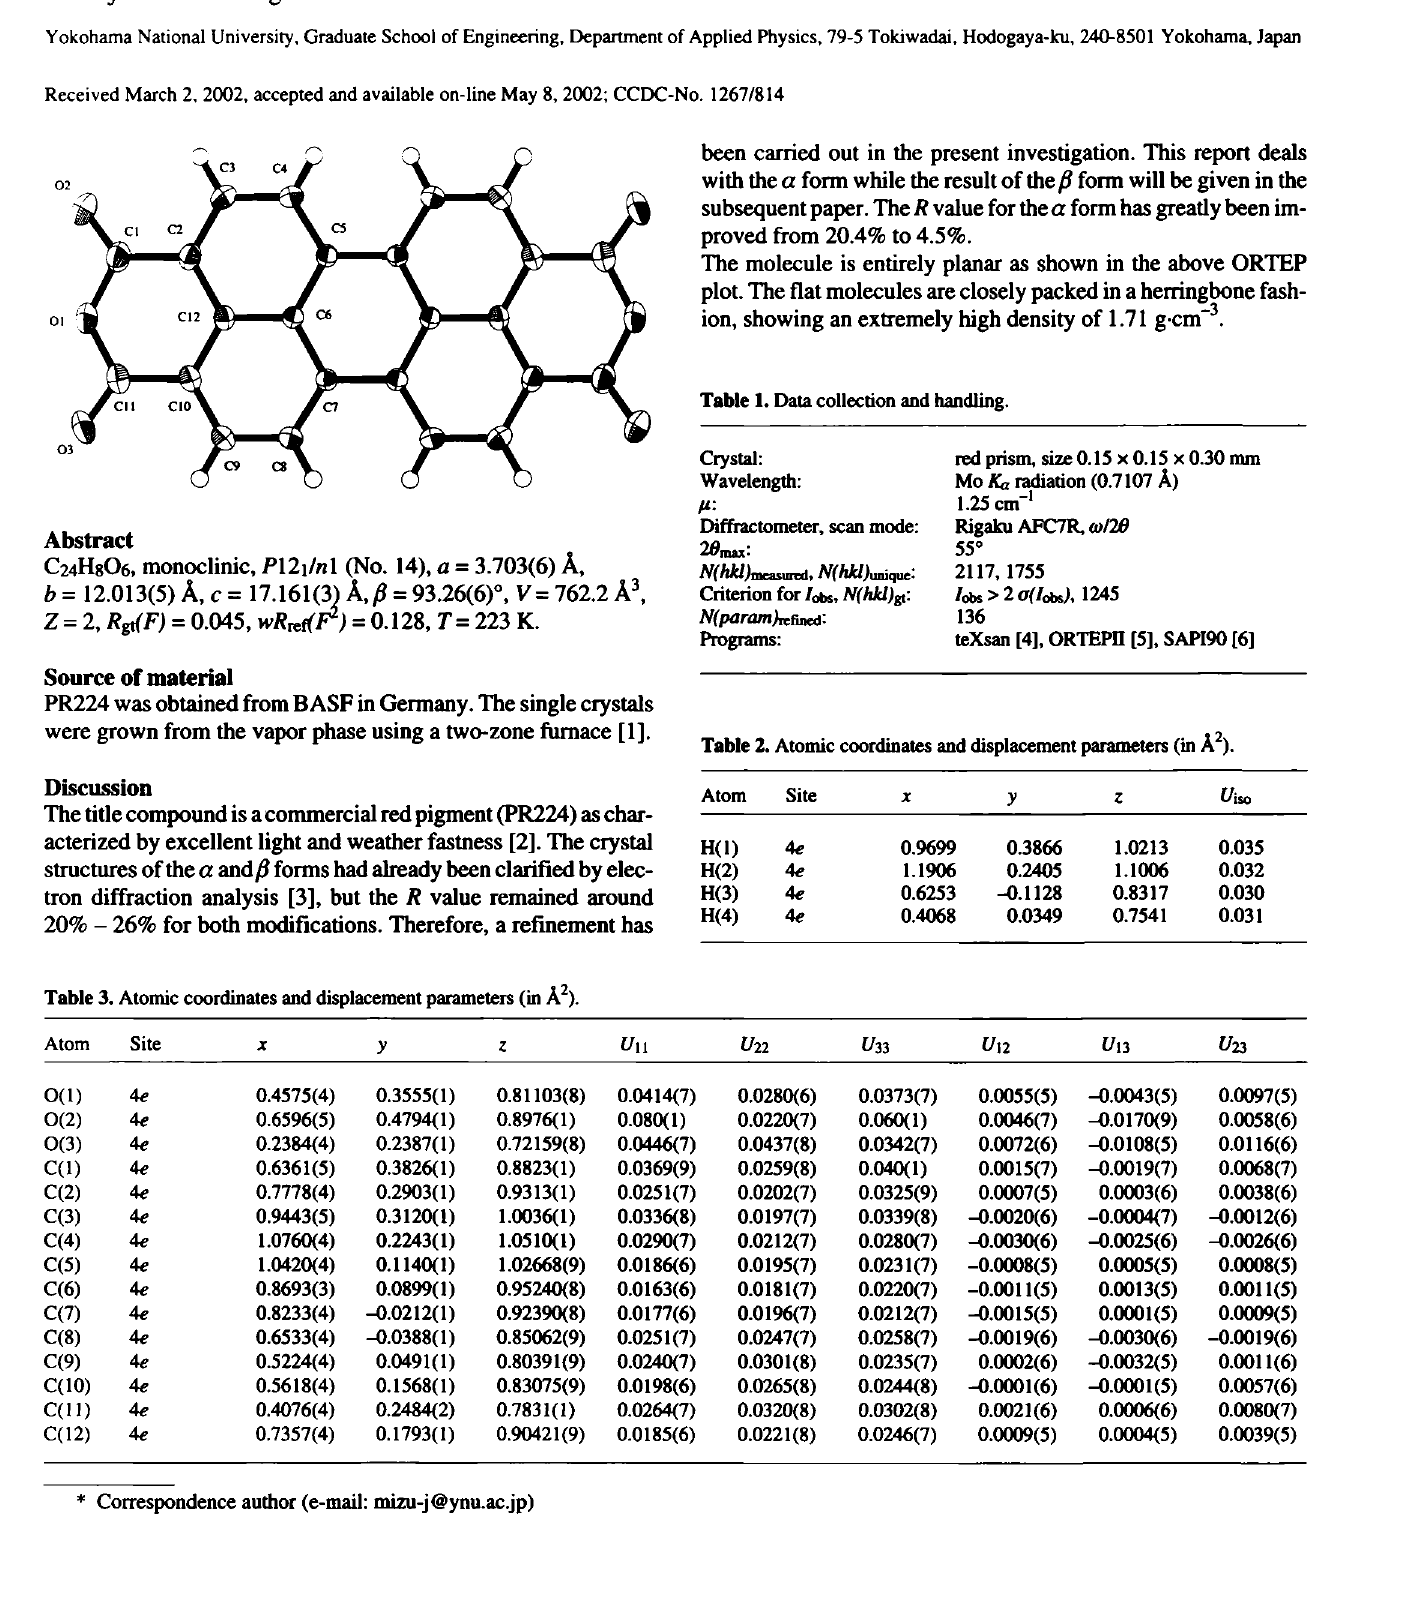
Table 3. Atomic coordinates and displacement parameters (in Â 2 ).